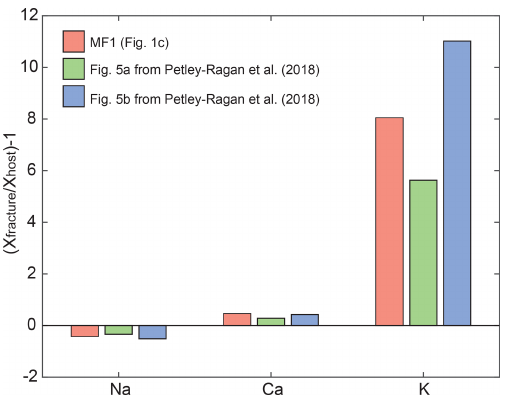
Figure 3. Mass balance of plagioclase microfractures. Three sep- arate plagioclase microfractures were analyzed for Na, Ca and K. X fracture is the bulk composition of the fracture, and X host is the bulk composition of the adjacent plagioclase